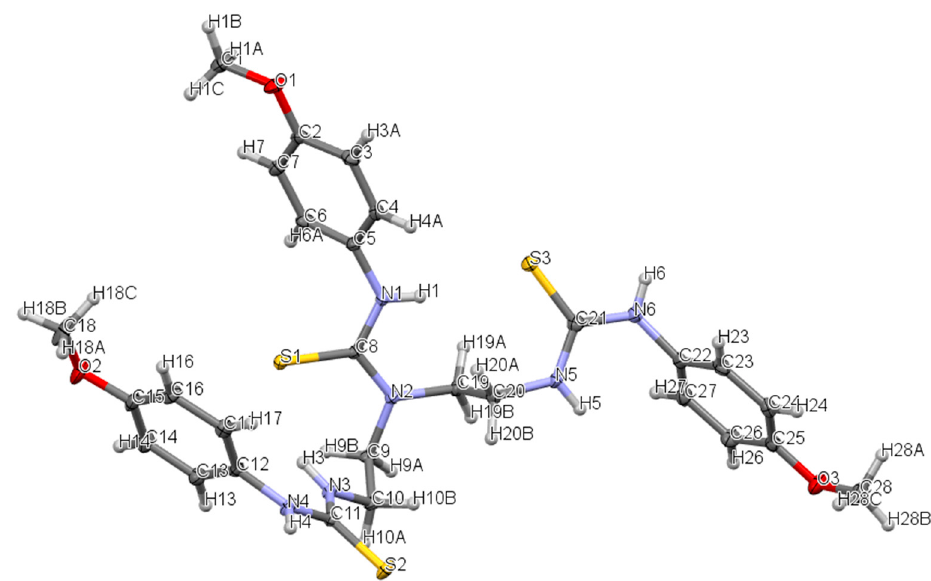
Figure 2. The molecular structure of 3-(4-methoxyphenyl)-1,1-bis{2-[3-(4-methoxyphenyl)thioureido]ethyl}thiourea ( 1 ) showing atom numbering and displacement ellipsoids at the 50% probability level.